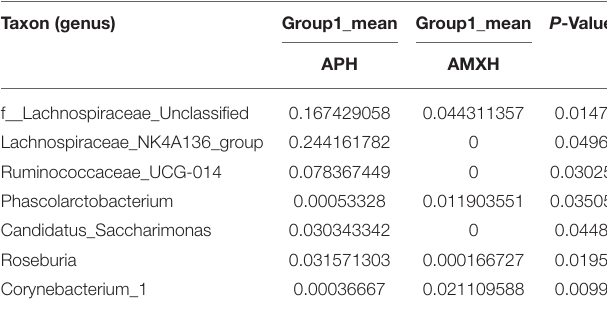
TABLE 11 | Based on Metastats analysis for flora differences between APH and AMXH groups under the